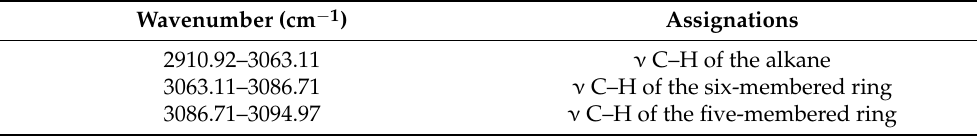
Table 2. Assignations of the bands of the saturate molecule vibration spectrum.